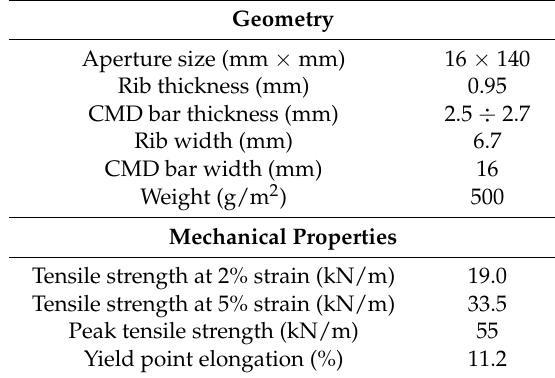
Table 1. Engineering properties of the uniaxial geogrid from Radiowo.